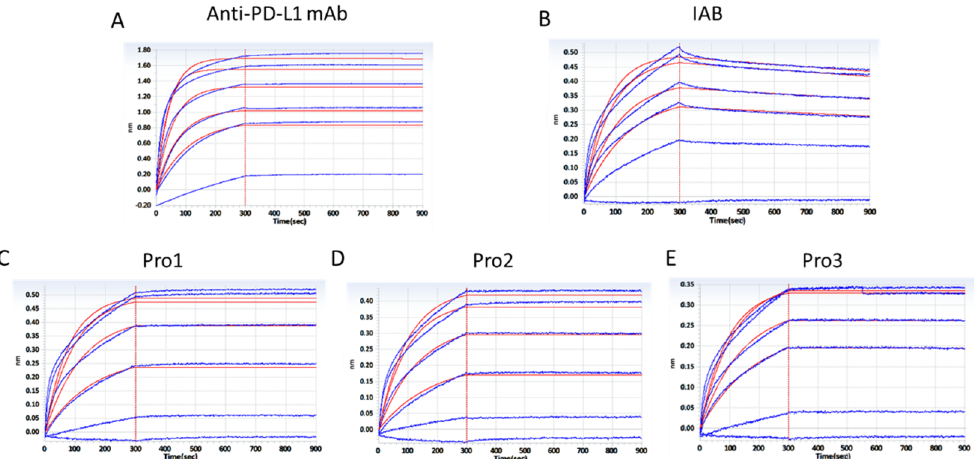
Figure 4. Affinity analysis of proteins binding to antigen PD–L1 through a BLI assay. ( A ) The positive control antibody; ( B ) prototype IAB; ( C ) Pro1; ( D ) Pro2; ( E ) Pro3. (Response units vs. time). Table 1. Rate and equilibrium constants of proteins binding to PD–L1.